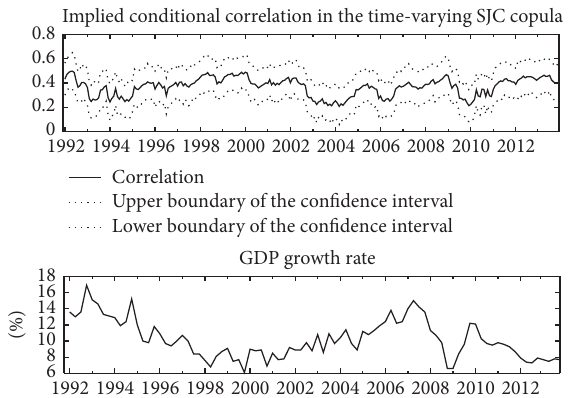
Figure 2: Implied conditional correlation in the time-varying SJC copula and Chinese GDP growth rate, with 95% confidence interval for the time-varying correlation.